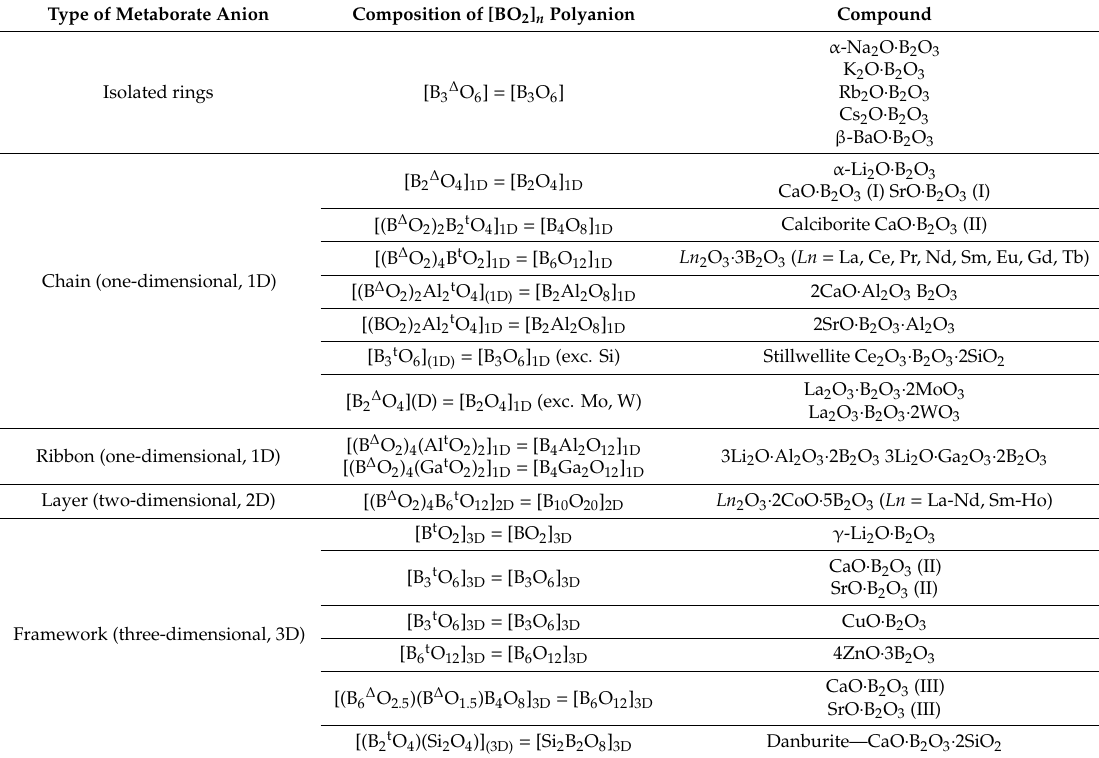
Table 1. Structural motifs based on the [BO 2 ] n metaborate